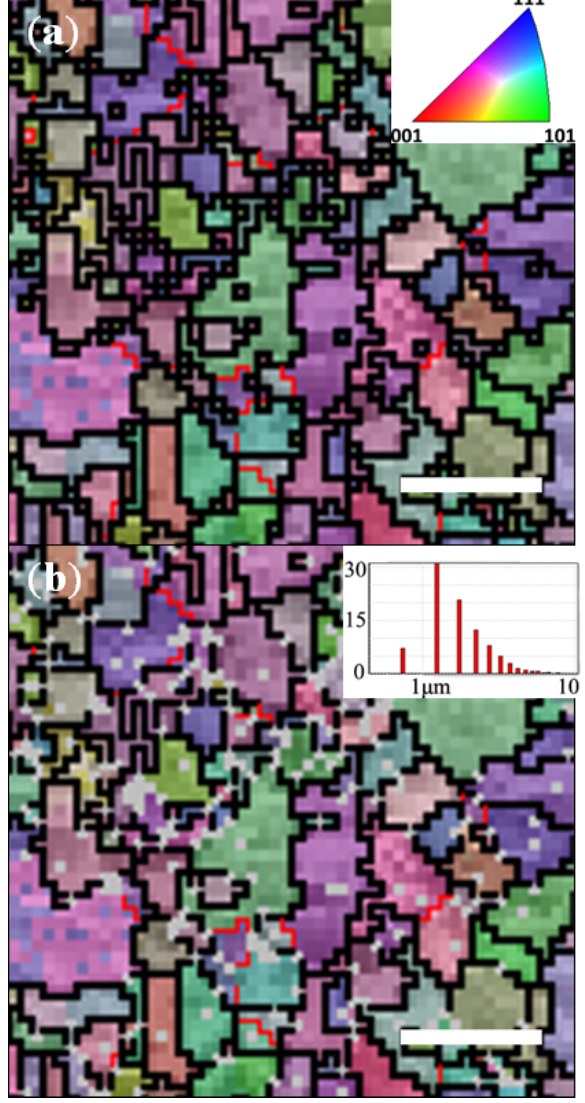
Figure 9. Electron back-scattered diffraction (EBSD) mapping on CuZn 30 alloy: ( a ) before DA; and ( b ) after DA. Scale bars correspond to 5 μm. See Figure S10 for full scale